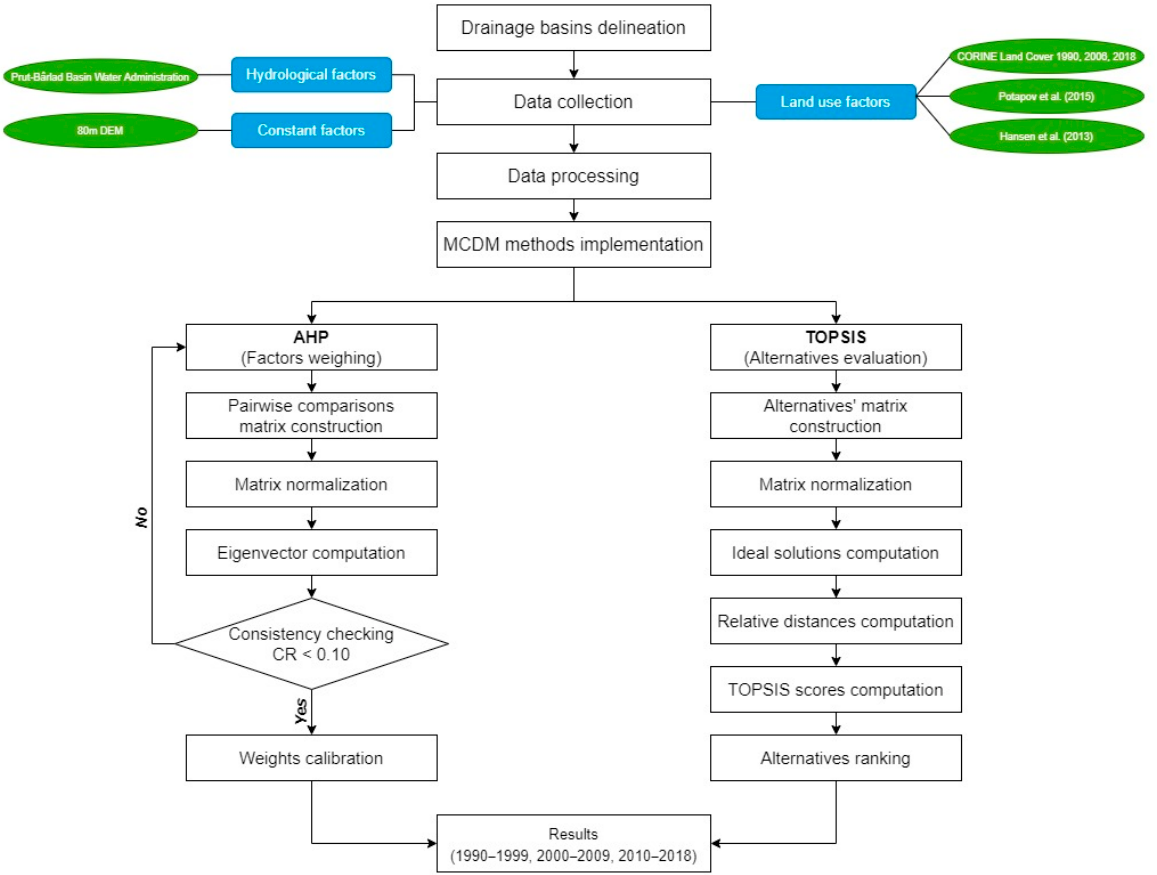
Figure 2. Methodological flowchart